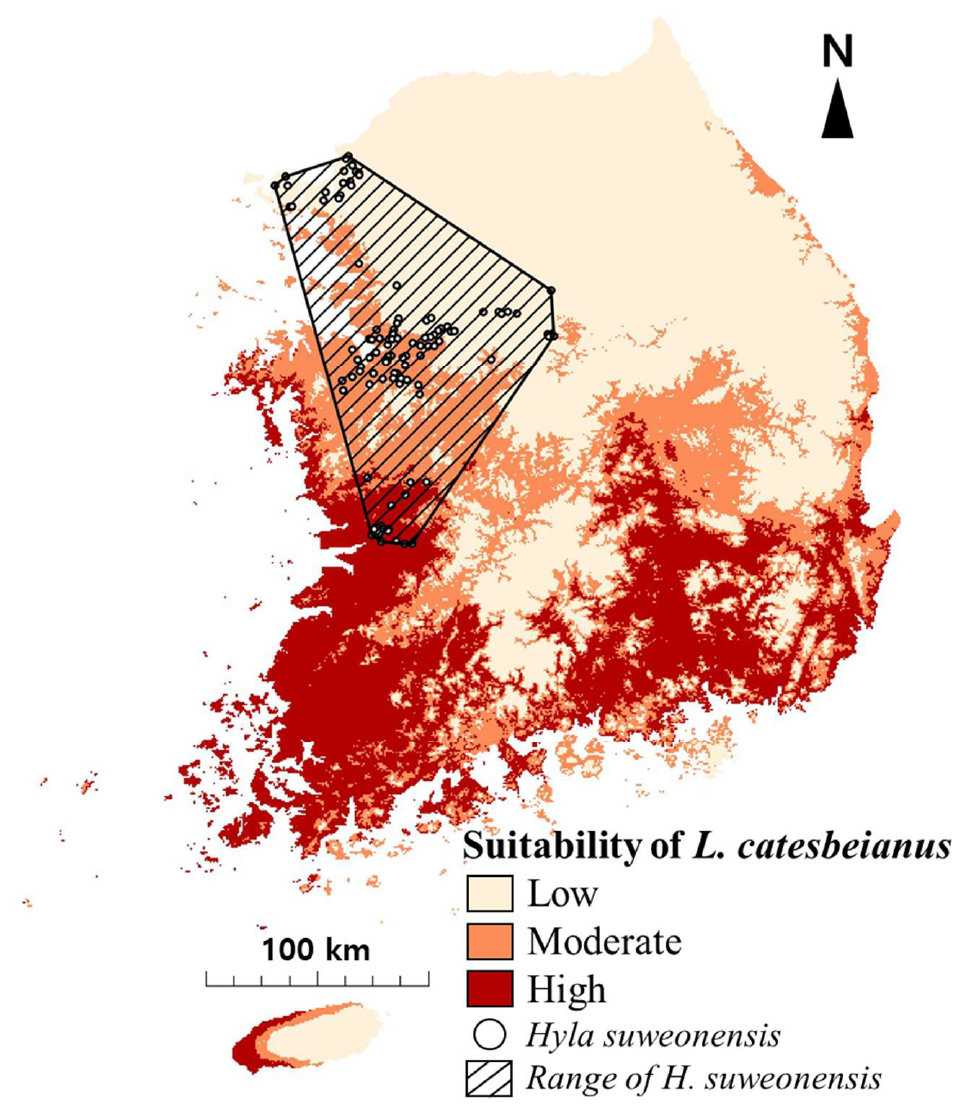
Figure 1. The potential distribution of Lithobates catesbeianus and the actual distribution points of Hyla Suweonensis in South Korea. Table 3. The number of overlapping points with the distribution of the Hyla Suweonensis according to the change in the distribution of Lithobates catesbeianus.